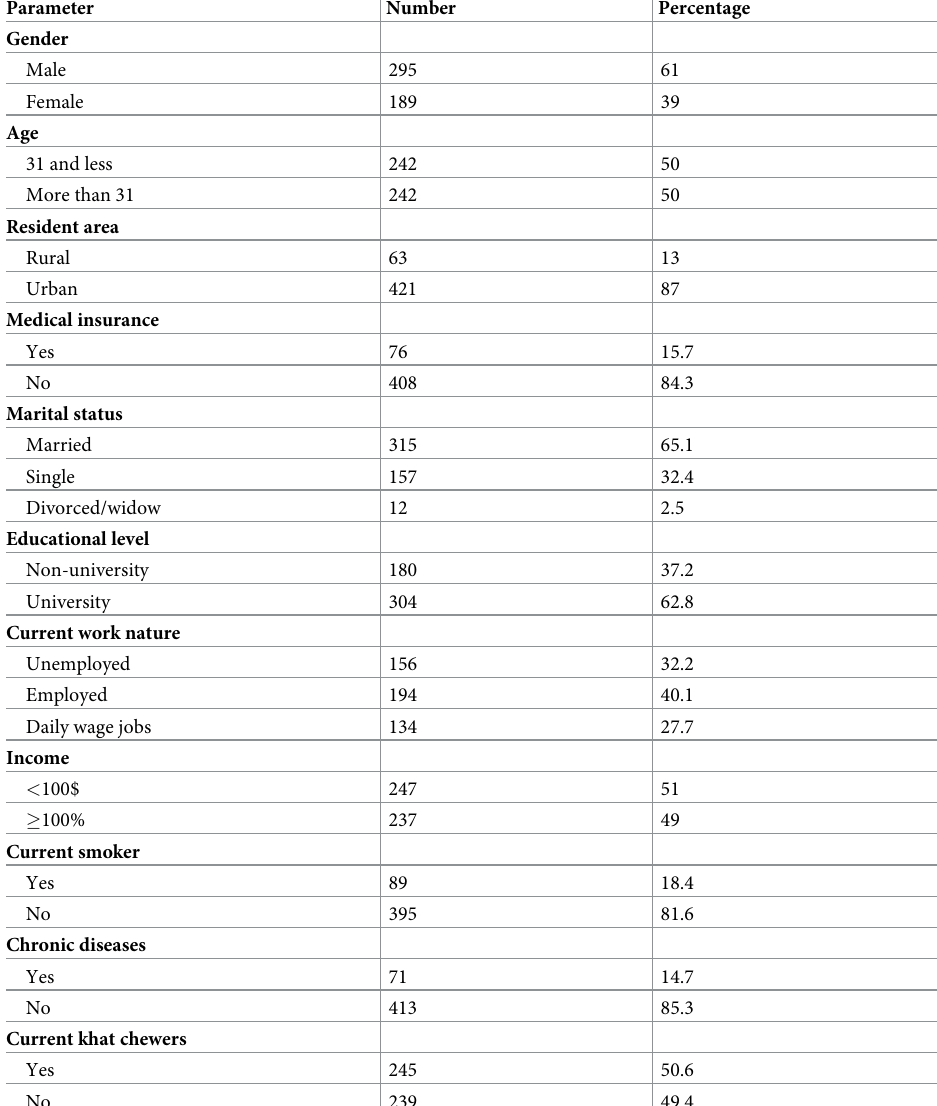
Table 1. Socio-demographic characteristics (n =